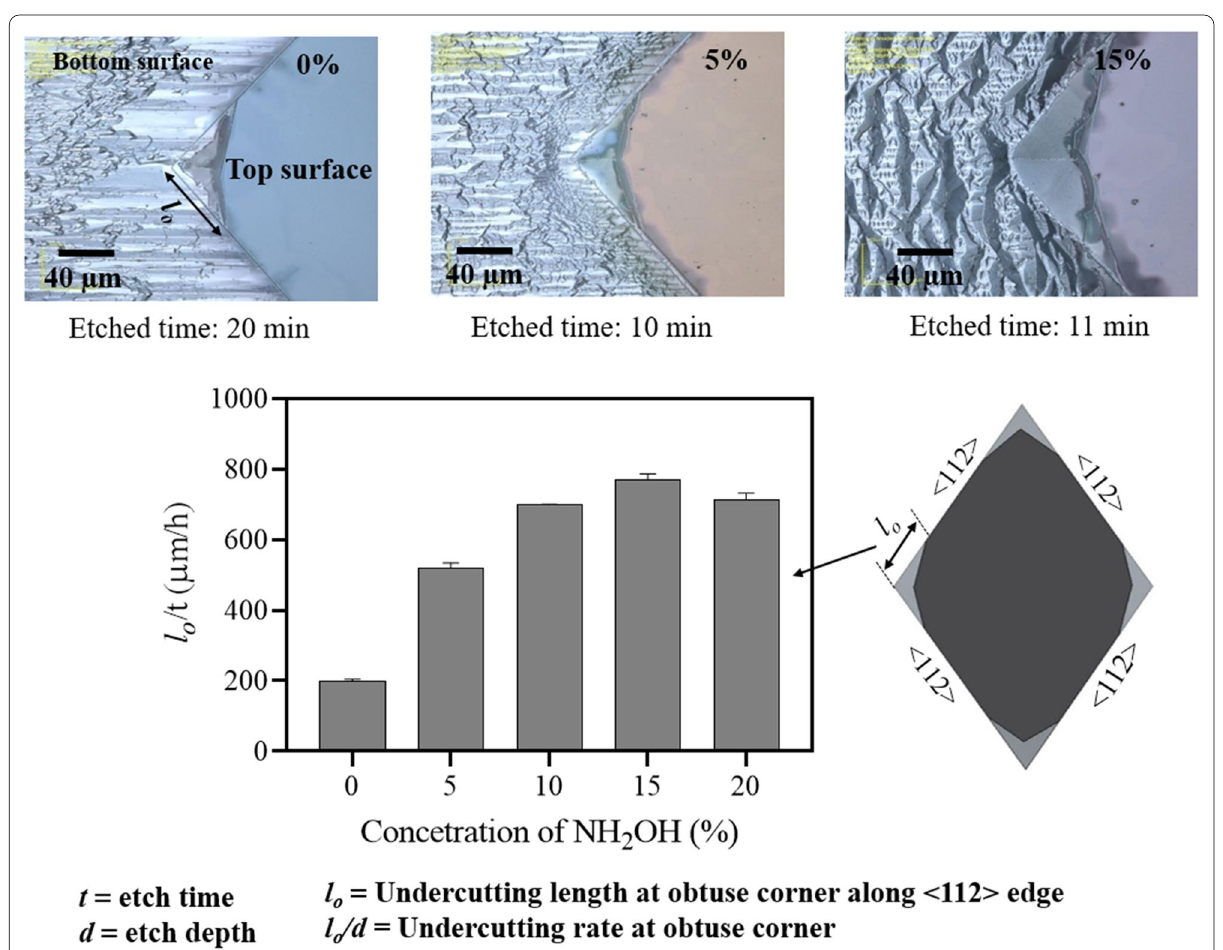
Fig. 59 Undercutting at obtuse corners on Si{110} surface in pure and different concentrations of NH 2 OH-added 20 wt% KOH at 75